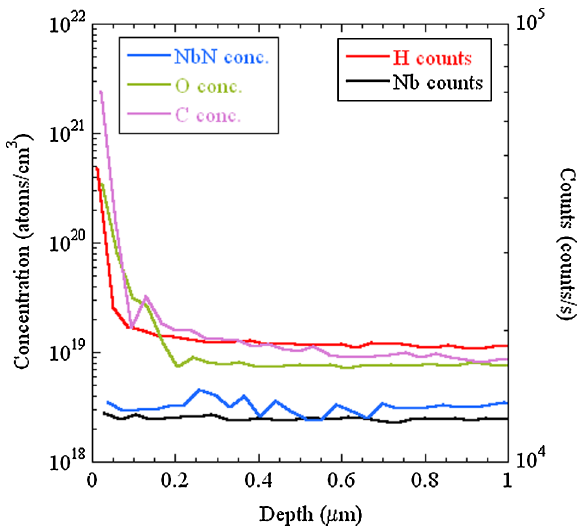
FIG. 27. (Color) SIMS reduced data depth profile for sample L7 (identical to L5) after additional 120 (cid:1) C = 48 h